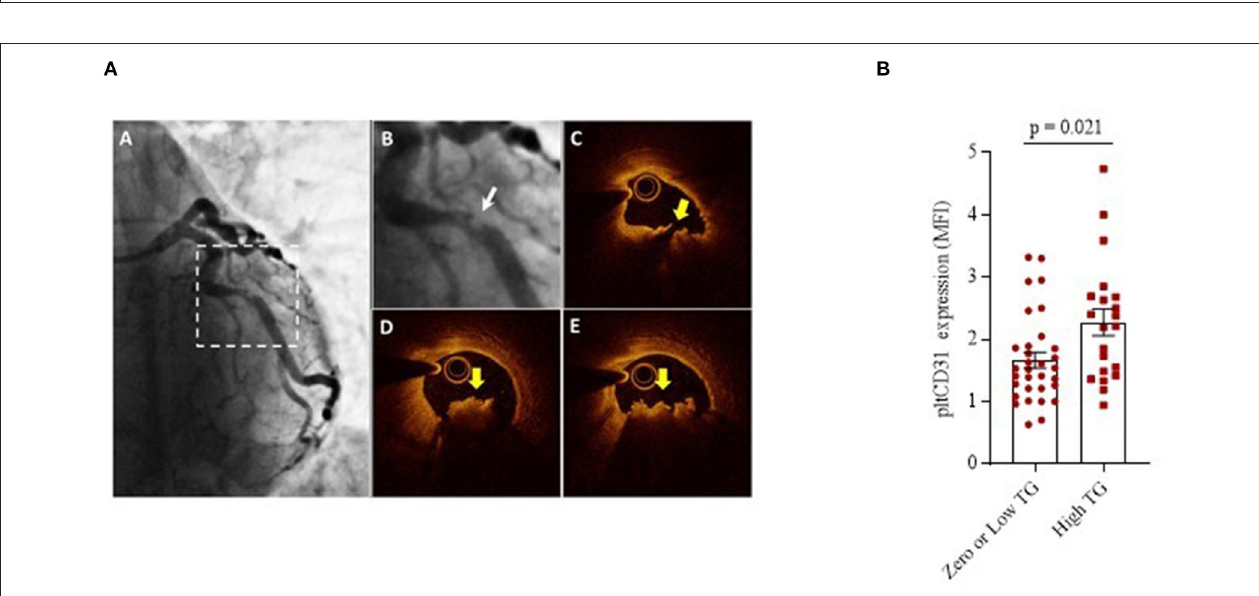
FIGURE 5 | Platelet CD31 expression and Thrombus-Grade evaluation. (A) Representative angiographic and OCT images of a plaque. (A) Coronary angiogram of the left coronary artery showing a culprit lesion on the left circumflex (dotted squared selection); (B) Magnification of the angiogram showing a complex culprit lesion with a thrombus grade 3 and a scalloped profile (Ambrose type II eccentric); (C) Corresponding OCT cross-sectional image showing a lipid-rich plaque with a disrupted fibrous cap (yellow arrow); (D,E) Adjacent OCT cross-sections showing a large thrombus (yellow arrows). (B) pltCD31 surface protein expression within NSTEMI group showing the differences between patients with zero/low and high thrombus grade at the site of culprit stenosis. Data were assessed by flow-cytometry (mean ± SD), in basal conditions (MFI, Median Fluorescence Intensity; plt CD31, platelet CD31; SD, Standard Deviation; and TG, Thrombus